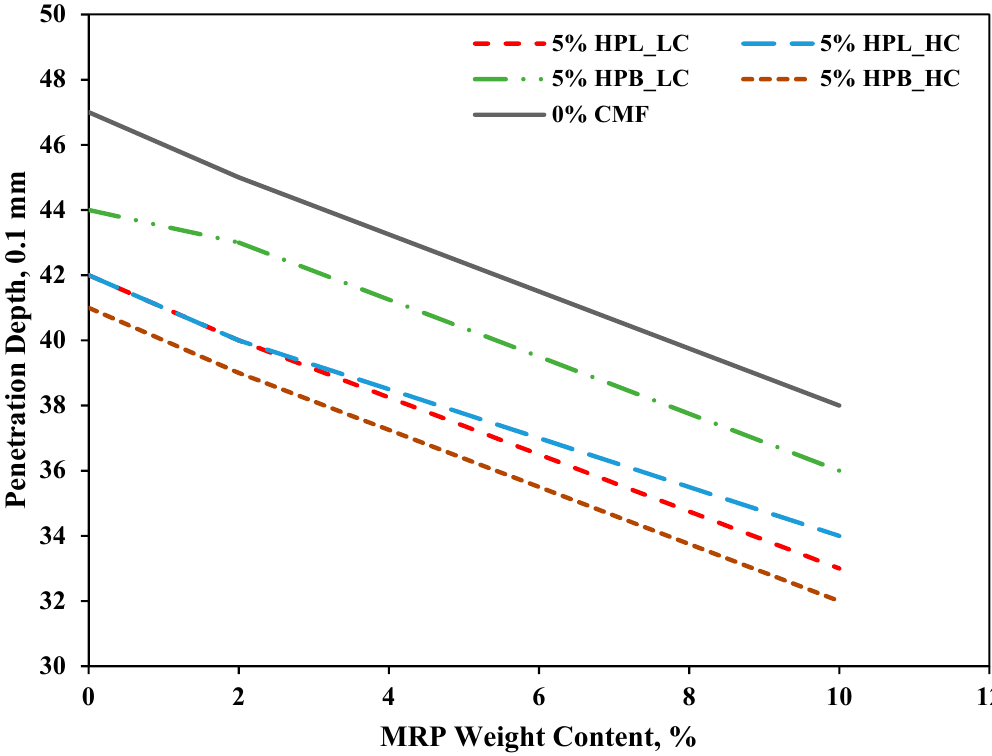
Figure 4. Effect of MRP content and CMF type on penetration depth at 0% and 5% CMF content.